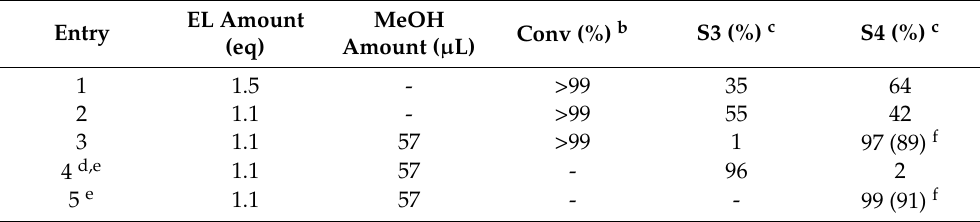
Table 2. Effect of 2 and methanol amount on the results obtained in the reaction of 1 and 2 a